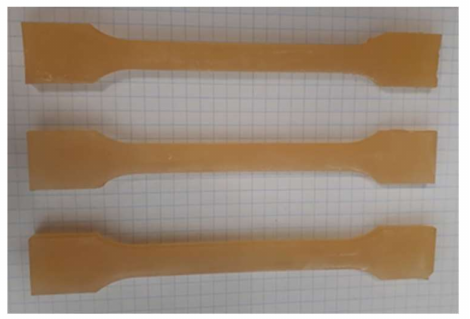
Figure 4. Dog-bone specimens of